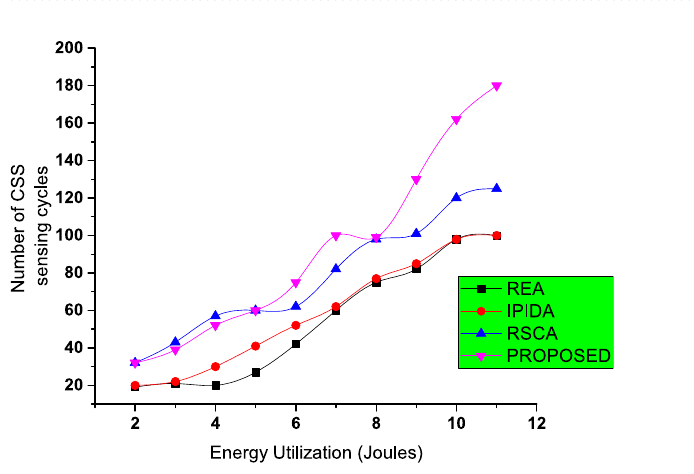
Figure 7. Comparison of energy utilization with existing